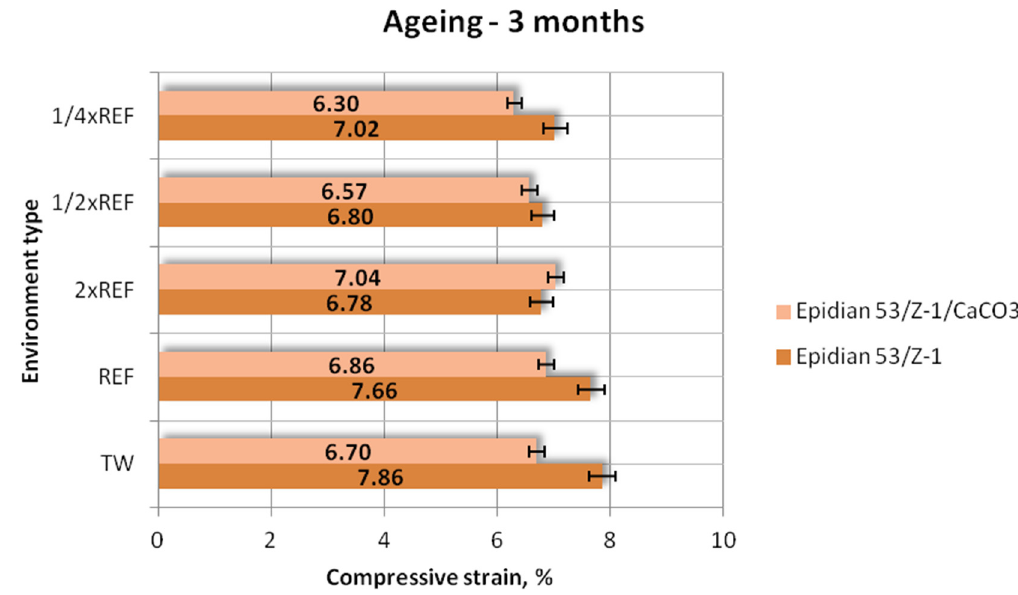
Figure 11. Compressive strain of the unmodified (Epidian 53 / Z-1) and modified (Epidian 53 / Z-1 / CaCO 3 ) epoxy adhesive compounds, aged for 3 months.